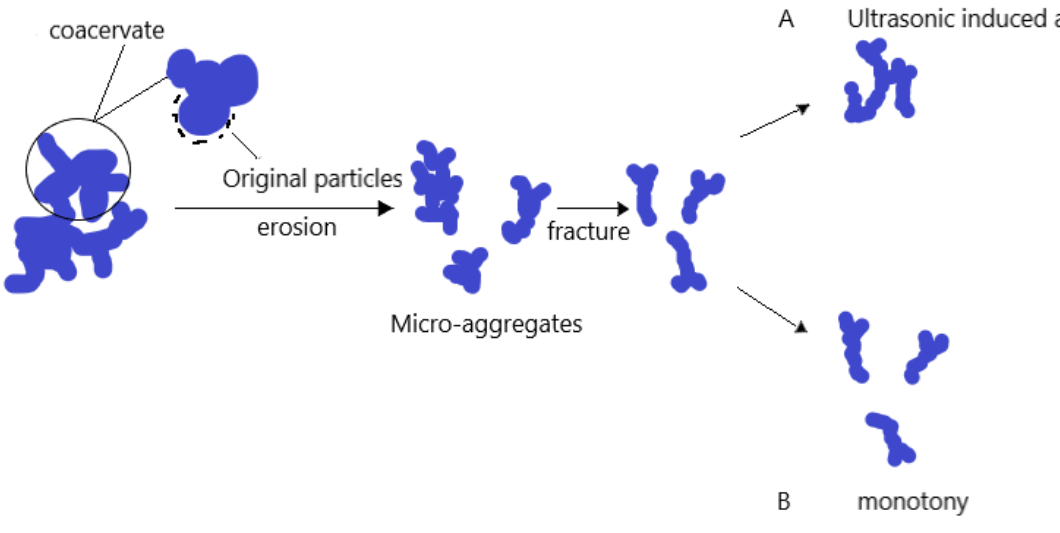
Figure 8. Ultrasonic dispersion effect diagram.